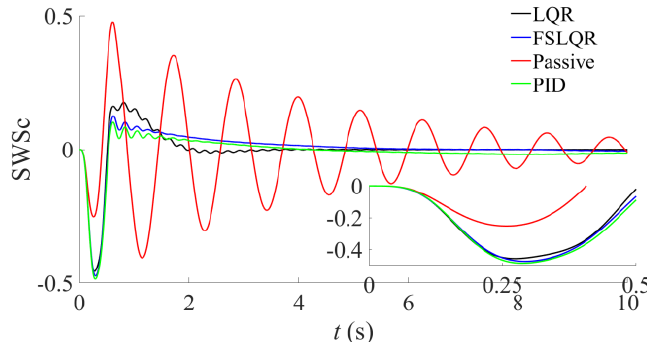
Figure 3. The suspension dynamic travel coefficient responses of SWSc under the impulse excitation.